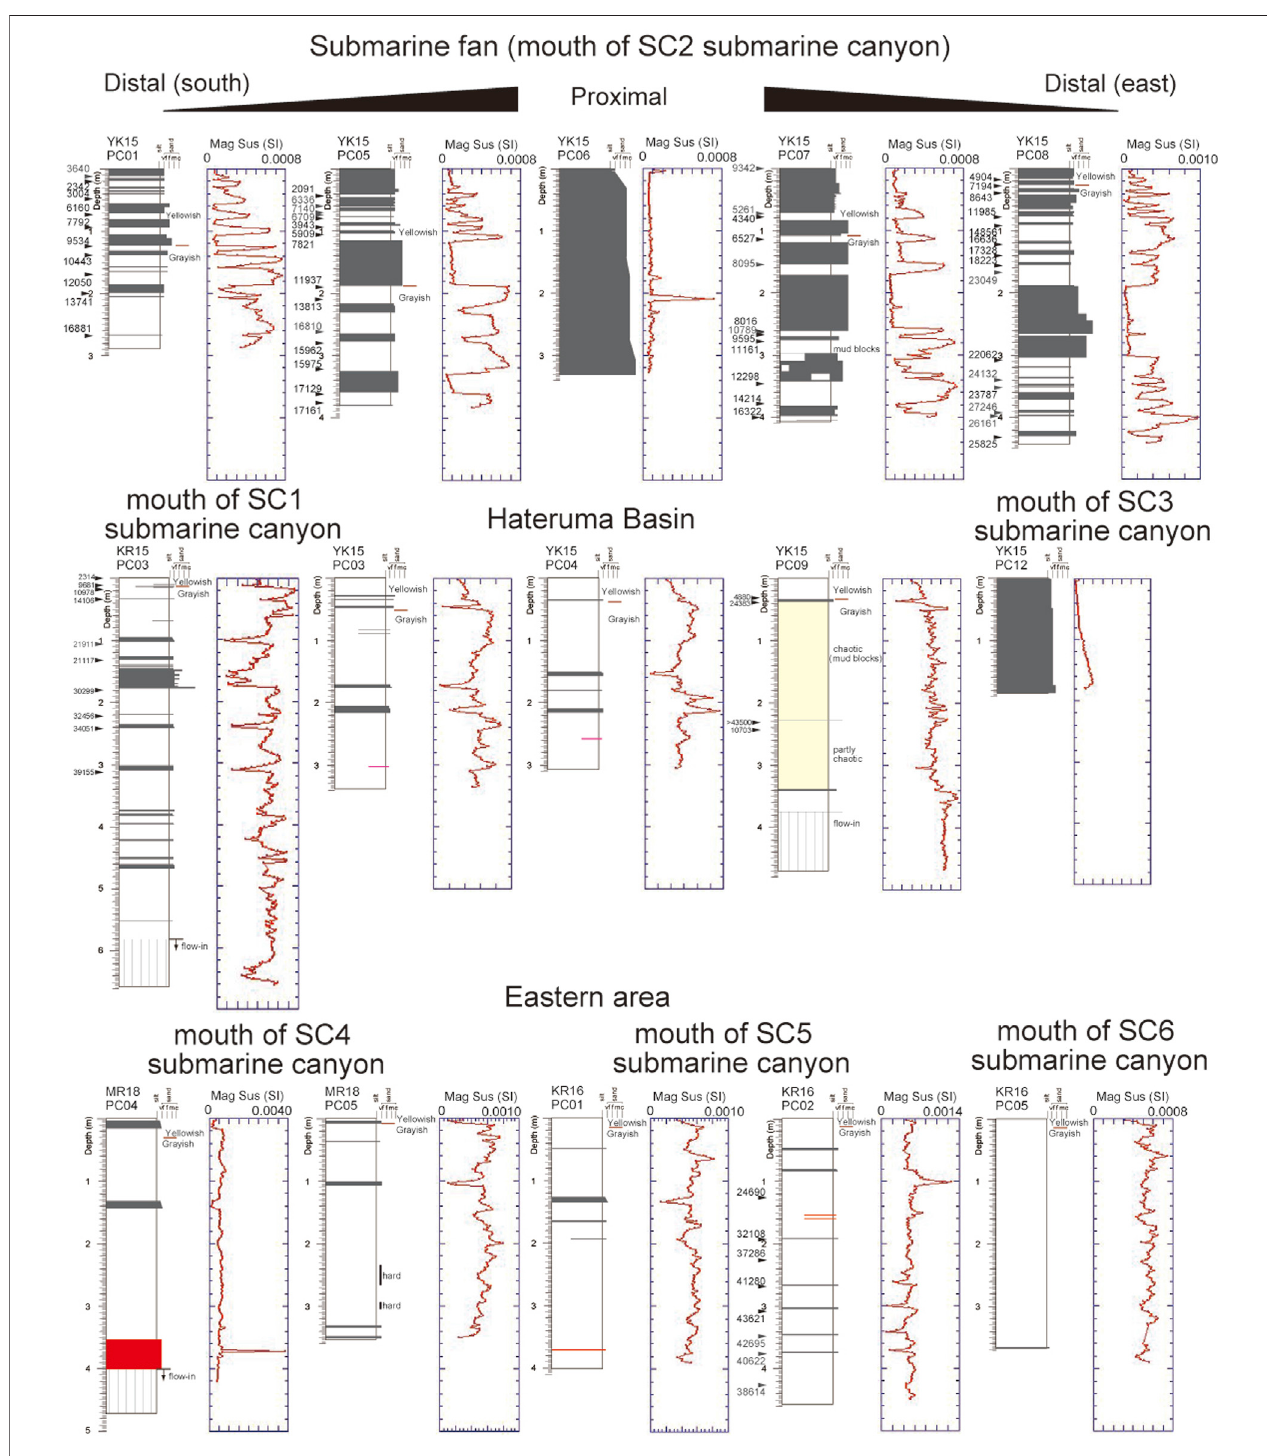
FIGURE 2 | Log section, magnetic susceptibility pro fi le, and radiocarbon dates of each core. Lithology: calcareous sand – coarse silt (gray), bioturbated silt (white), chaotic mud (yellow), and tephra (red).